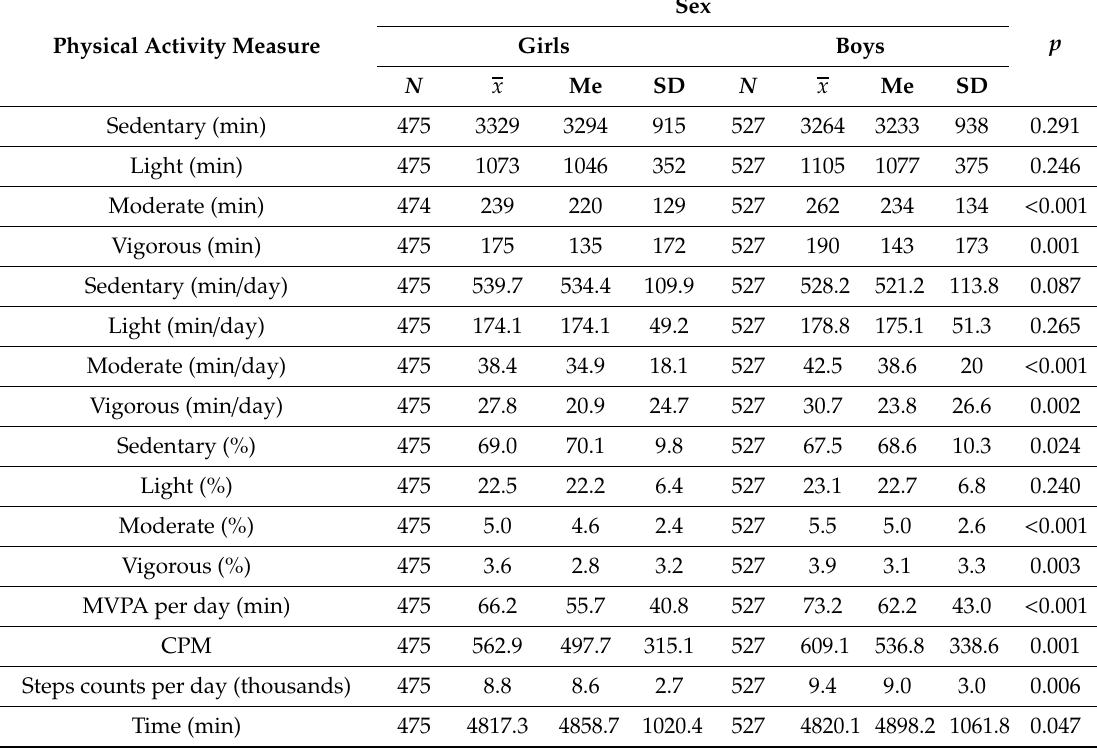
Table 1. Characteristics of parameters describing the level of physical activity of the participants depending on